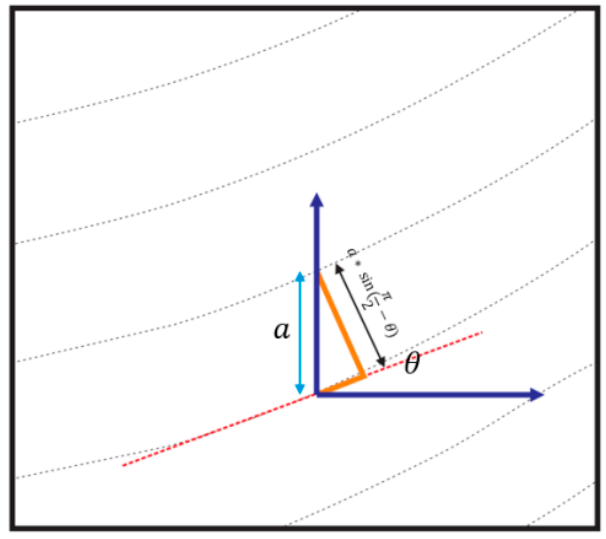
Figure 5. Schematic of the geometric calculation of the vertical distance between two curvilinear paths.